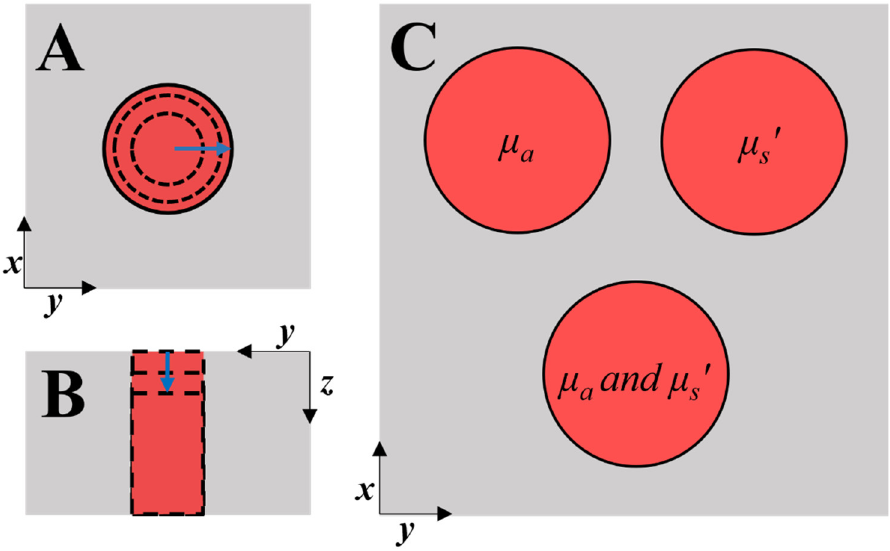
Figure 6. Anomaly slab models. ( A ) Varying radii cylindrical anomaly model for a range of absorption values. ( B ) Varying depth cylindrical anomaly model for a range of absorption values. ( C ) Tri-anomaly model containing three fixed-radii cylindrical anomalies, varying different optical properties.